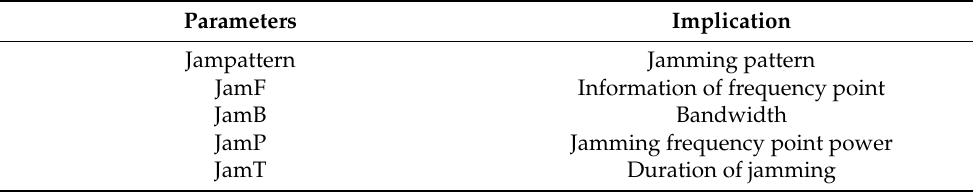
Table 3. Sensing parameters of time-frequency domain feature